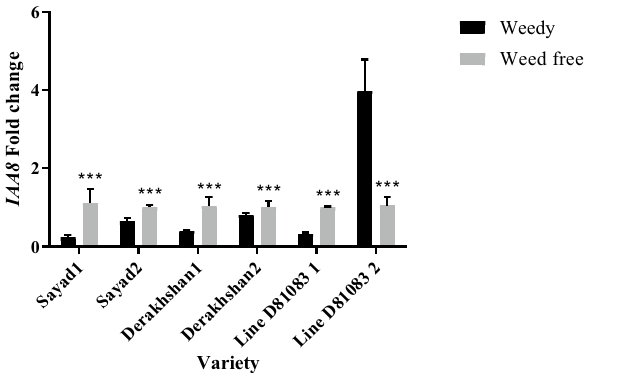
Figure 4. Real-time PCR (qRT-PCR) analysis of IAA8 gene transcript levels in two treatments weedy and weed free, in the three cultivars/lines studied and in two stages of sampling V4 and R7 (data are the mean ± standard error in five biological replications and five technical replications, numbers 1 and 2 next to the name of the cultivar represent the V4 and R7 stages, respectively). ***: P <